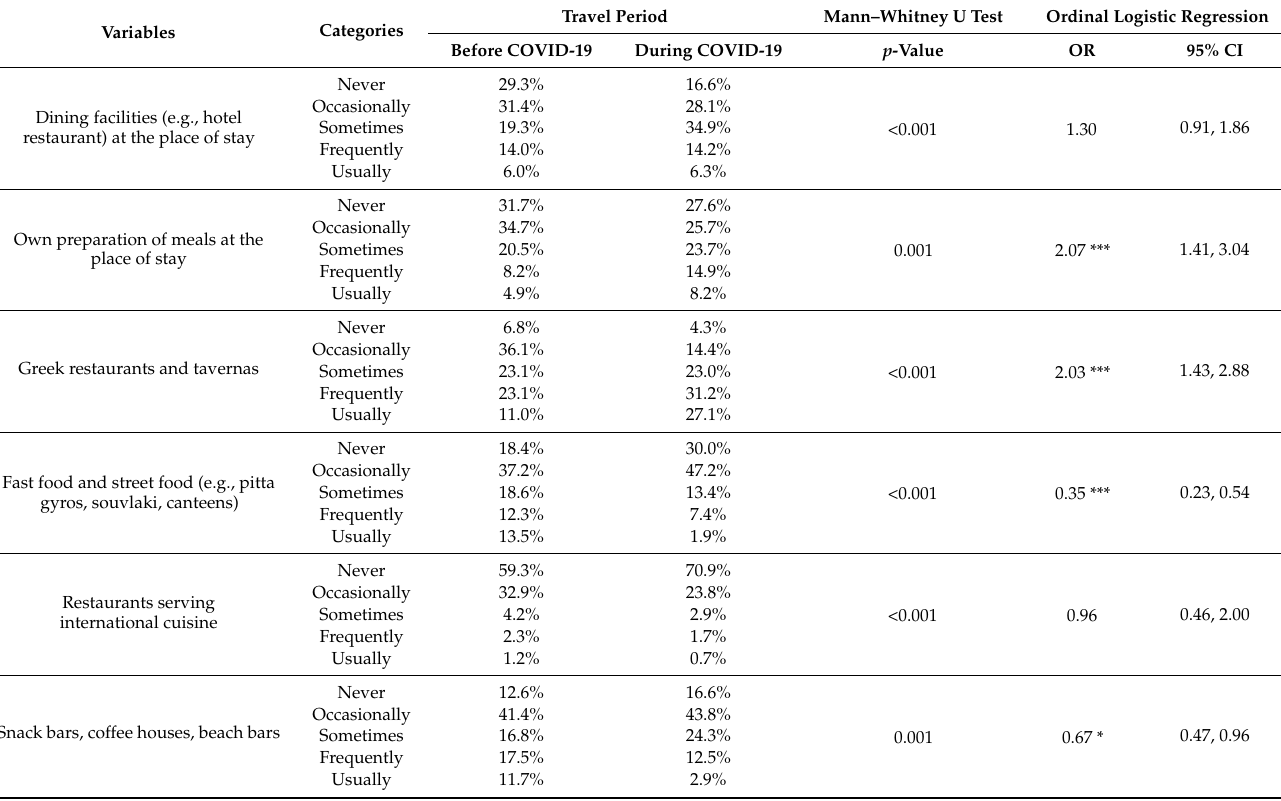
Table 4. Dining facilities used by tourists in each